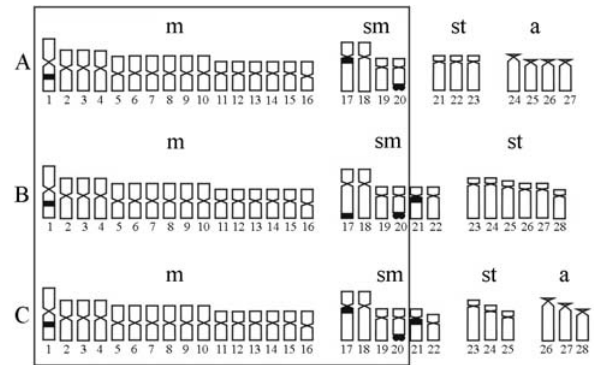
Figure 1 - Idiogram representative of the chromosome set in A) P. fur , B) P.maculatus andC) Pimelodus sp..Thedarkcirclescorrespondtonucleo- lar organizing regions and the shaded regions to the 5S rDNA gene local- izations. Highlighted is the part of the chromosome set macroscopically similar in the three analyzed species.